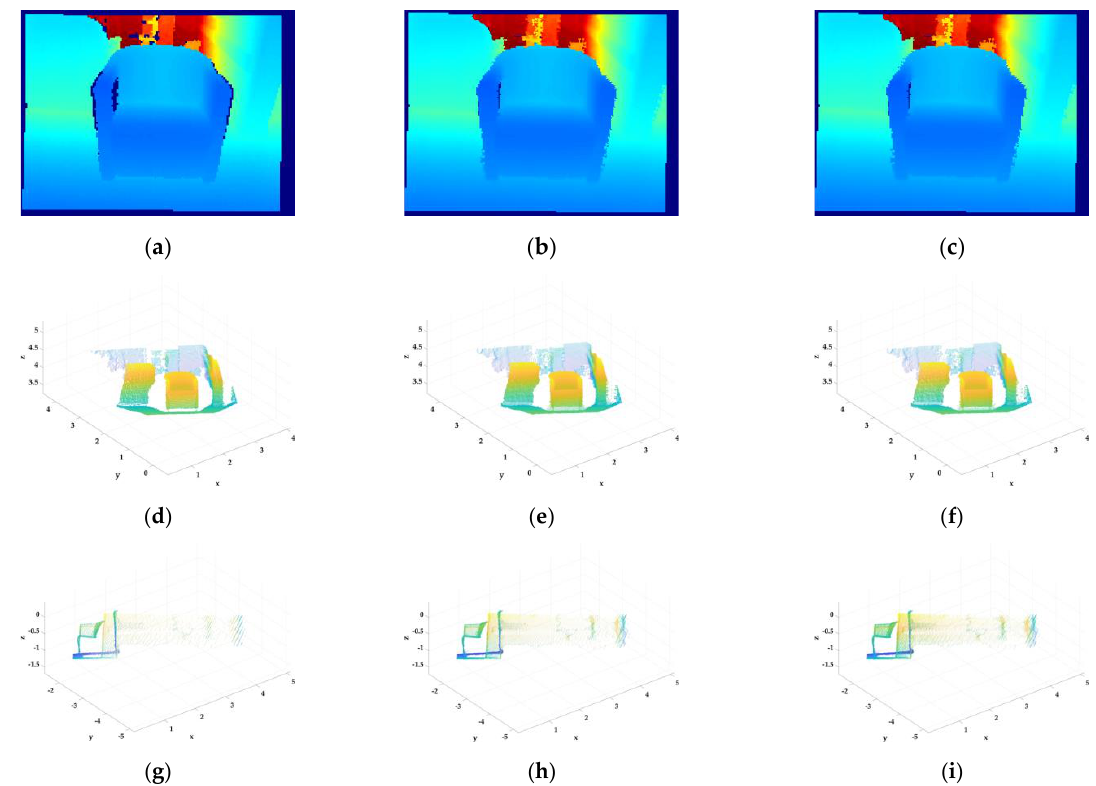
Figure 12. Validation of fractional-order differential Kriging interpolation super-resolution model (dataset no. 00333). ( a , d , g ) Original depth images; ( b , e , h ) Outputs of fractional-order differential Kriging interpolation super-resolution model ( ν = 0.6, PSNR = 28.828 dB); ( c , f , i ) Outputs of nearest- neighbour interpolation super-resolution model (PSNR = 25.385